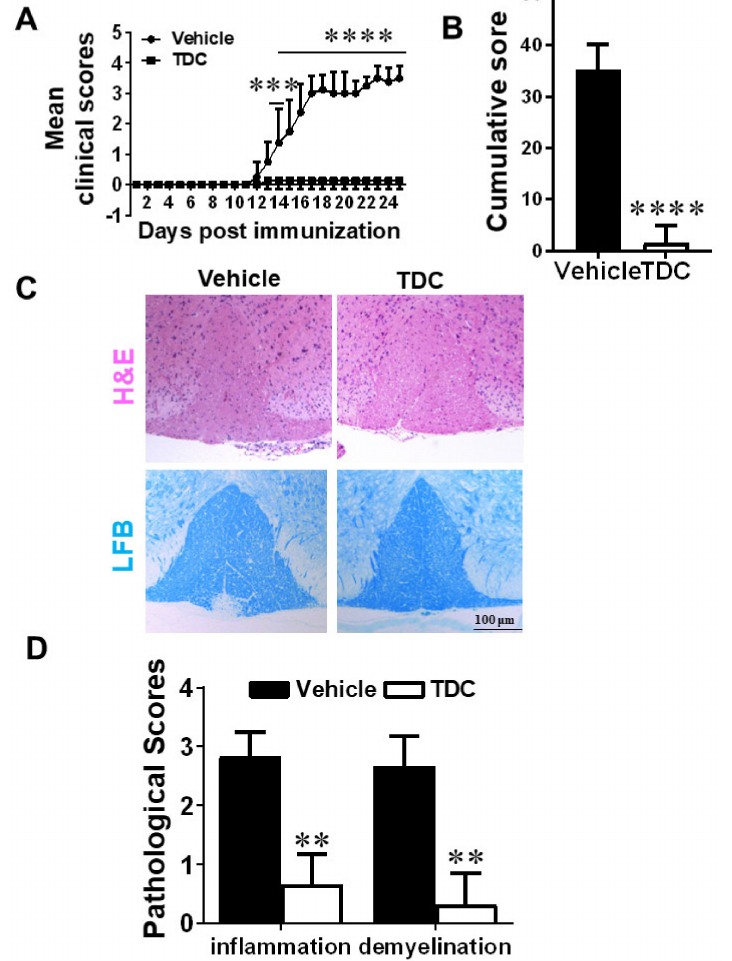
Figure 2. TDC ameliorated the progress of EAE. ( A ) EAE development was evaluated and recorded following a 0–5 scale. ( B ) Cumulative Score of EAE. Clinical scores were cumulated from day 10 p.i. to day 25 p.i. ( C ) Pathological sections at the lumbar level were stained to evaluate the degree of inflammatory infiltration (H&E), ( D ) The pathology scores of inflammation area were evaluated. Data are shown as mean ± SD ( n = 3 each group) and representative three experiments. ** p < 0.01, *** p < 0.001, **** p < 0.0001, compared to vehicle-treated group, unpaired t test ( B , D ) or two-way ANOVA with multiple comparisons test ( A ). Scale bar = 100 µ